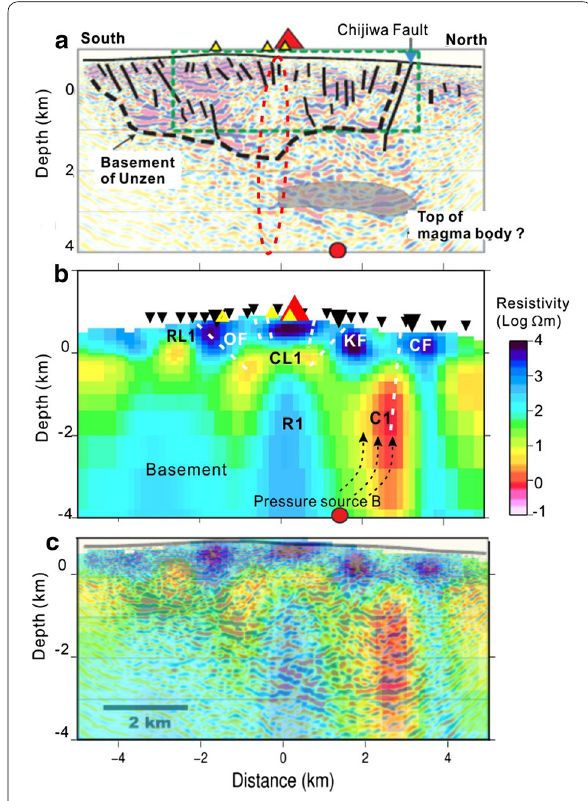
Fig. 8 a Cross section of the seismic reflection survey and interpretation (modified from Matsumoto et al. 2012). Red dashed ellipse in the center of the profile marks a possible conduit. b N–S vertical slice of the 3-D resistivity structure. (Location is shown in Fig. 4.) c The figures a , b are overlaid. Inverted triangles show MT measurement sites (large triangles: MT sites; small triangles: telluric sites). White dashed lines indicate the inferred deep extension of faults ( CF Chijiwa Fault, KF Kusenbu Fault, OF Oshidorino-Ike Fault; shorter lines are minor or unnamed faults). Pressure source B is indicated by a red solid circle. Black dashed arrows represent the inferred movement of released volatiles. See text for